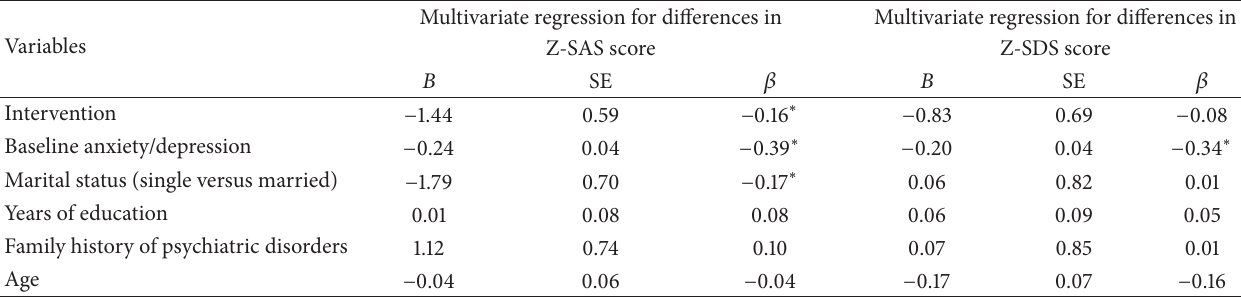
Table 2: Multivariate linear regression analyses for the changes in Z-SAS and Z-SDS scores before and after HSG. Multivariate regression for differences in Multivariate regression for differences in Variables